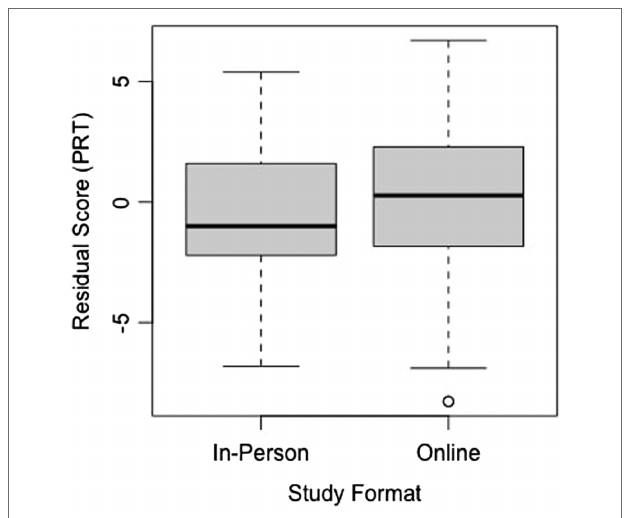
FIGURE 8 | Residual scores for both formats of the mental rotation task.